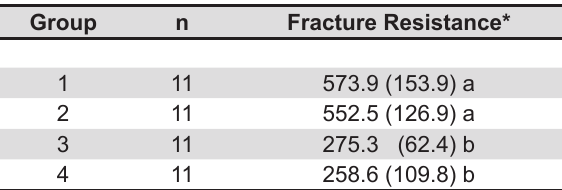
Table 1- Means and standard deviations of fracture resistance (N) for the four